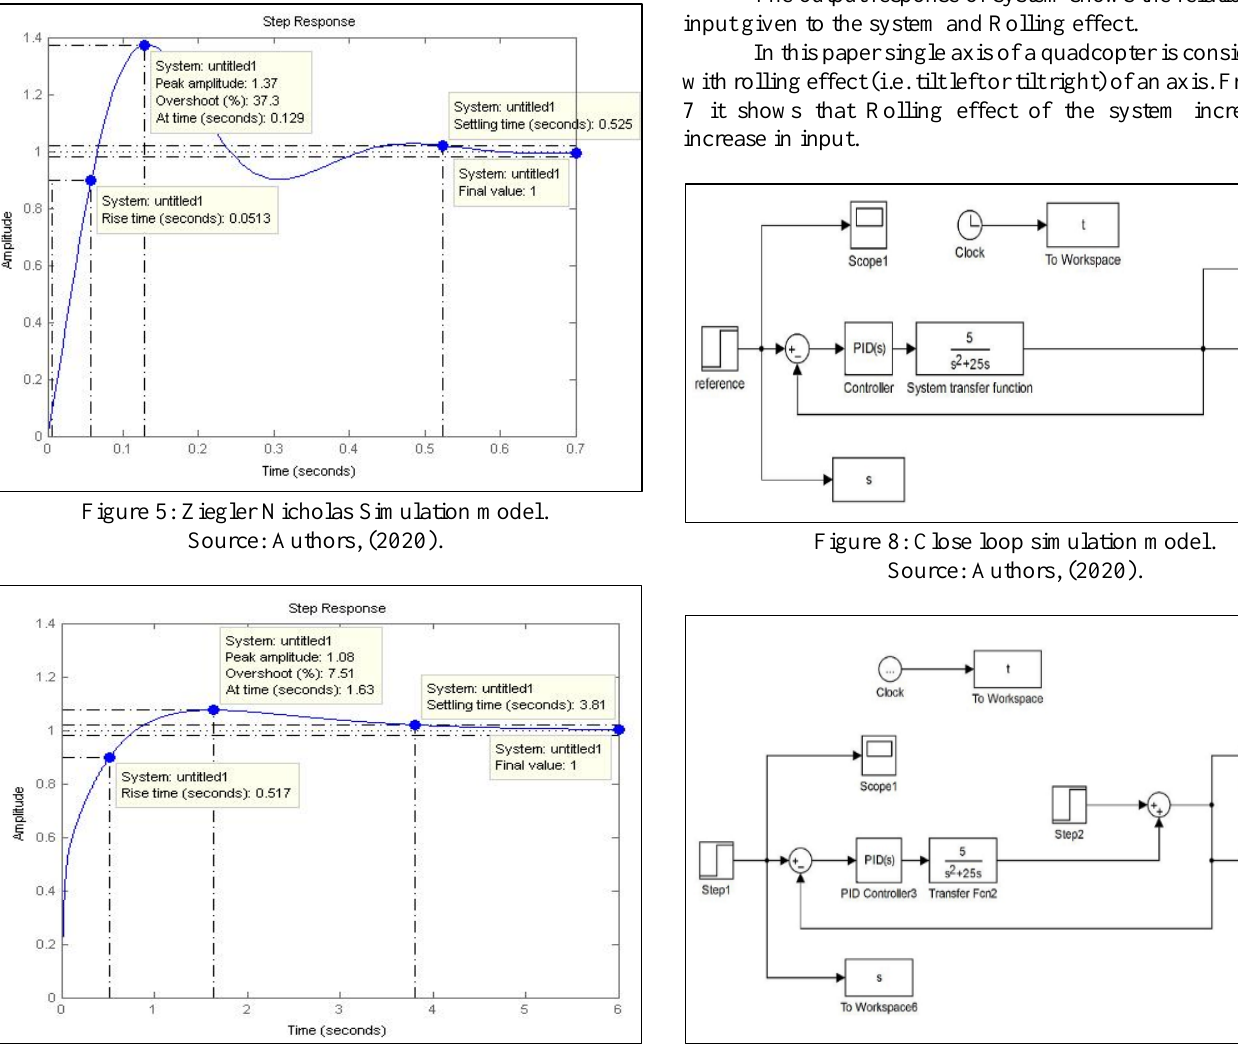
Figure 9: Disturbance rejection simulation